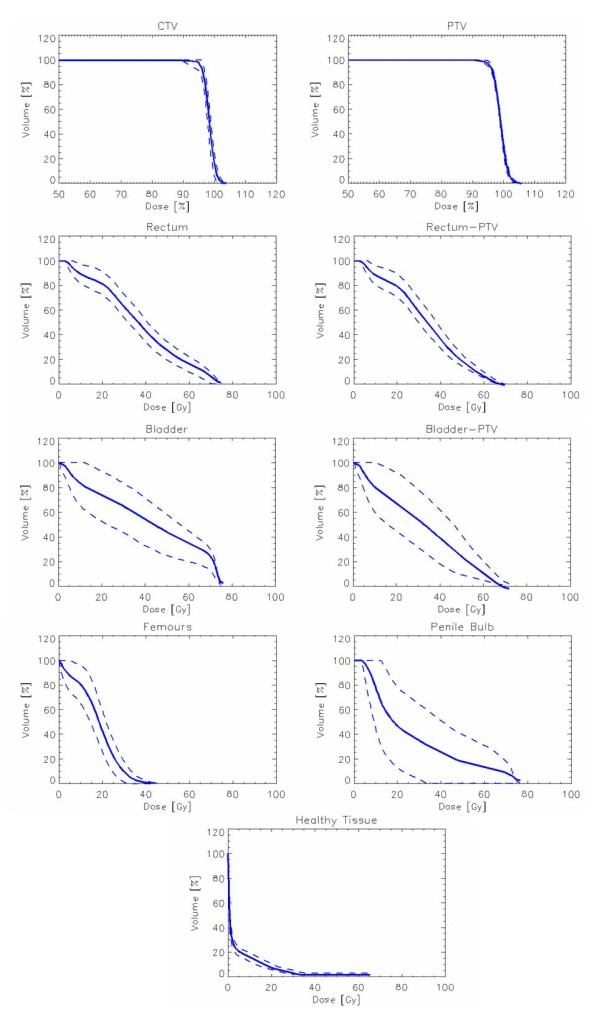
Average Dose Volume Histograms for CTV, PTV, Bladder, Rectum, Femurs, Penile Bulb and Healthy Tissue for RA plans. Dashed lines represent inter-patient variability at 1 standard deviation